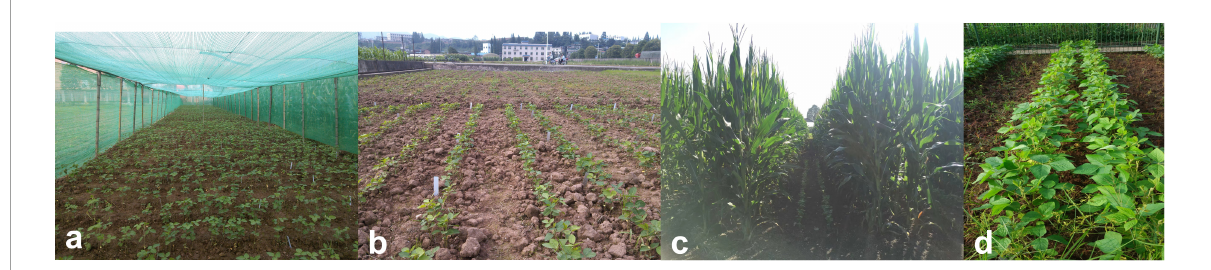
FIGURE1 Photographes of the experiment. (a) Shade treatment in 2014; (b) full sun light treatment in 2014; (c) maize-soybean relay strip intercropping in 2015; (d) soybean monoculture in